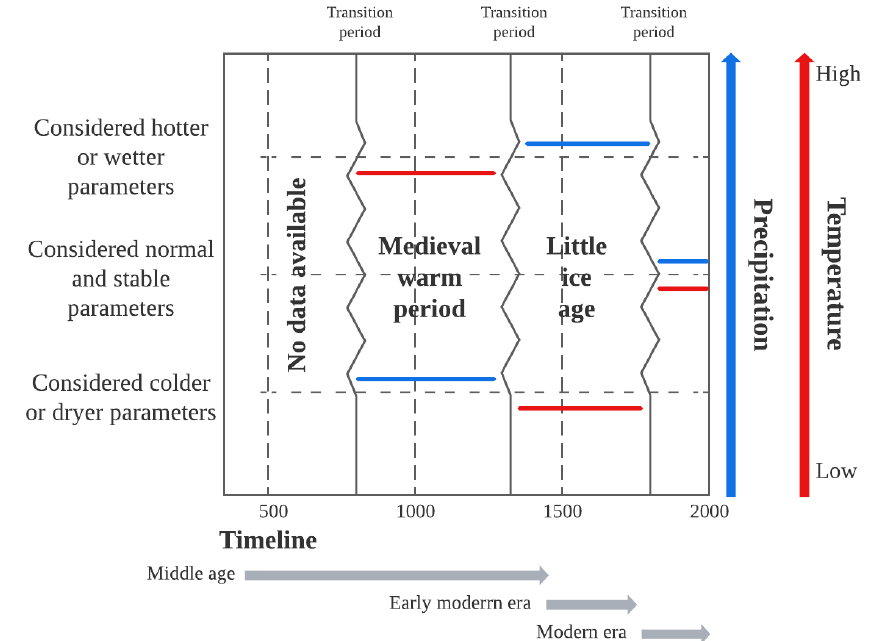
Figure 4. Climate reconstitution from Medieval to Modern Era.